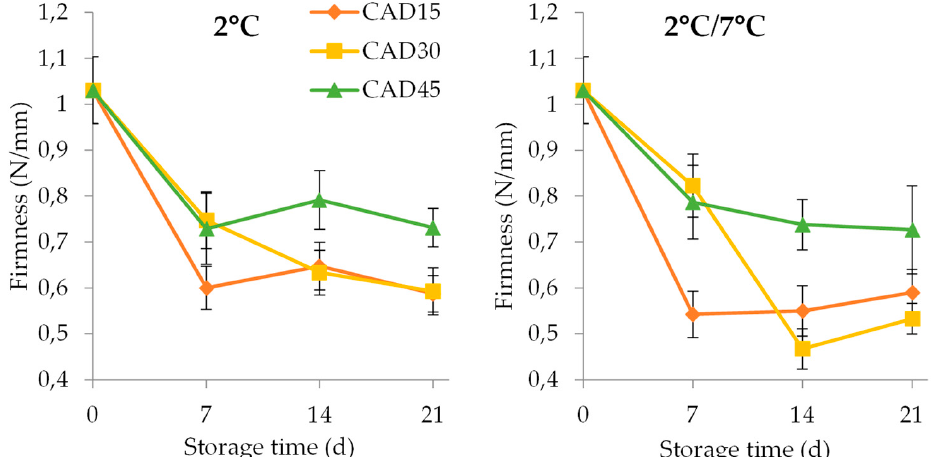
Figure 4. Firmness evolution of broccoli florets packaged in films with different levels of micro- perforation (CAD15, CAD30 and CAD45) throughout storage at 2 °C and 2 °C/7 °C. Vertical bars represent standard error (n = 5).